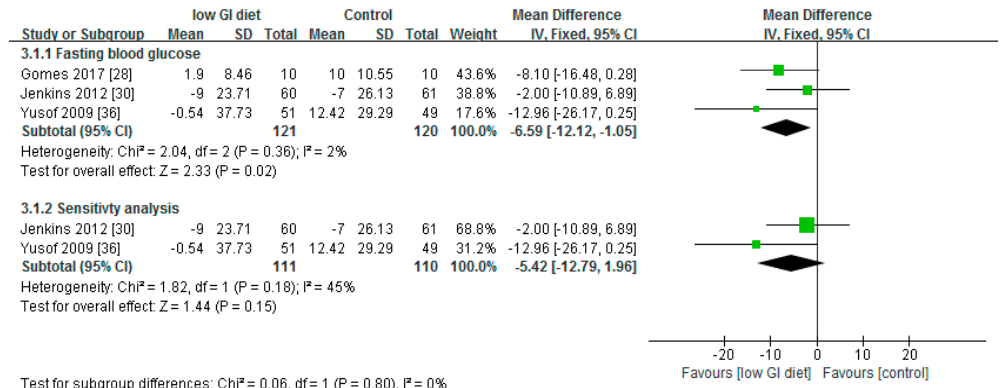
Figure 5. A forest plot showing the effect of low-GI diet on fasting blood glucose (mg/dL).